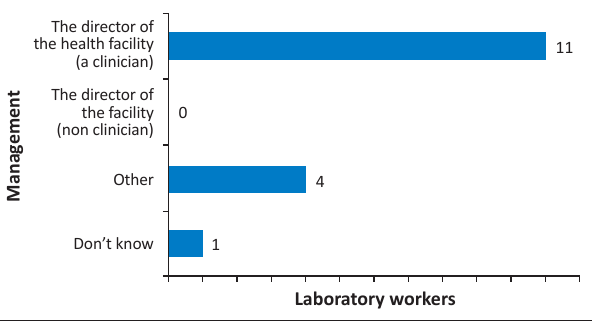
FIGURE 2: Factors related to the management of the organisation, response of laboratory staff.